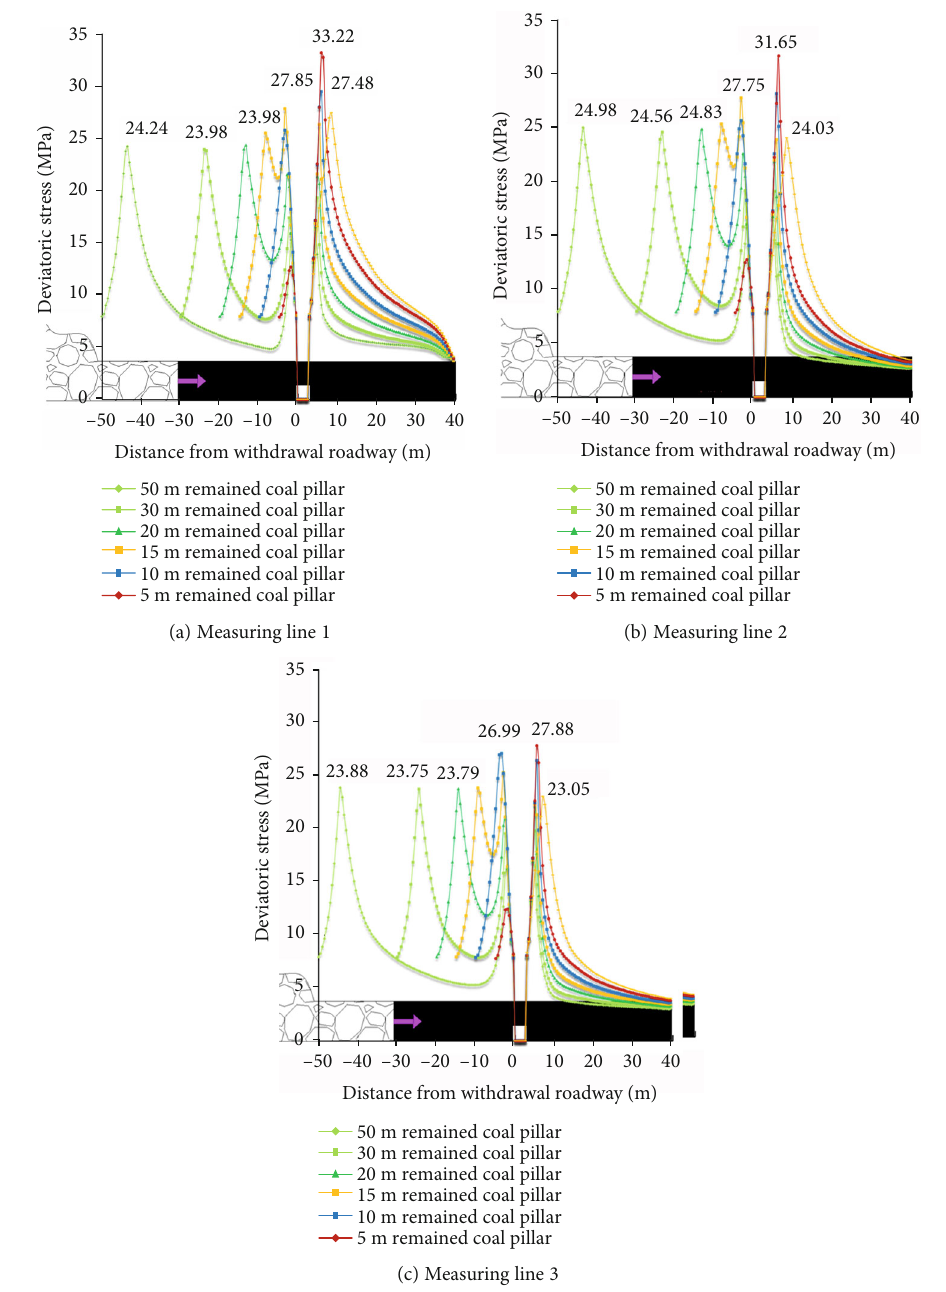
Figure 9: Variation trend of deviatoric stress of coal pillars on both sides of the withdrawal channel during fi nal